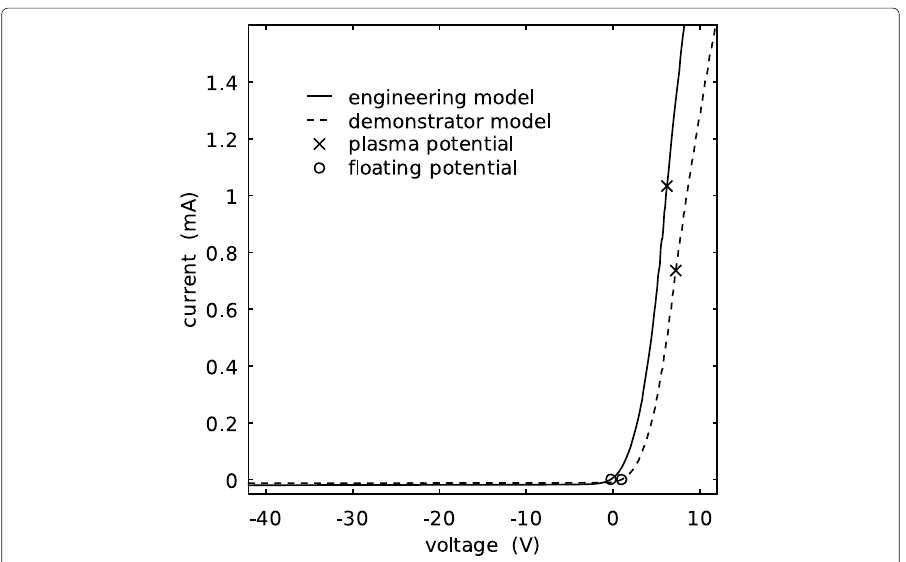
Fig. 16 LP measurements with the two sensors in the secondary plasma of a HEMPT. The two characteristics show quasi-simultaneous measurements with the two versions of the plasma sensor, i.e. engineering and demonstrator model. The aquisition time was